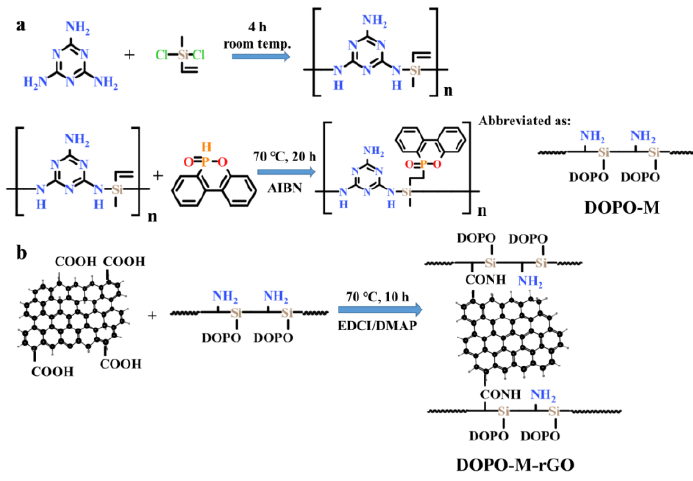
Figure 1. Synthetic route of ( a ) DOPO-M and ( b ) DOPO-M-rGO.